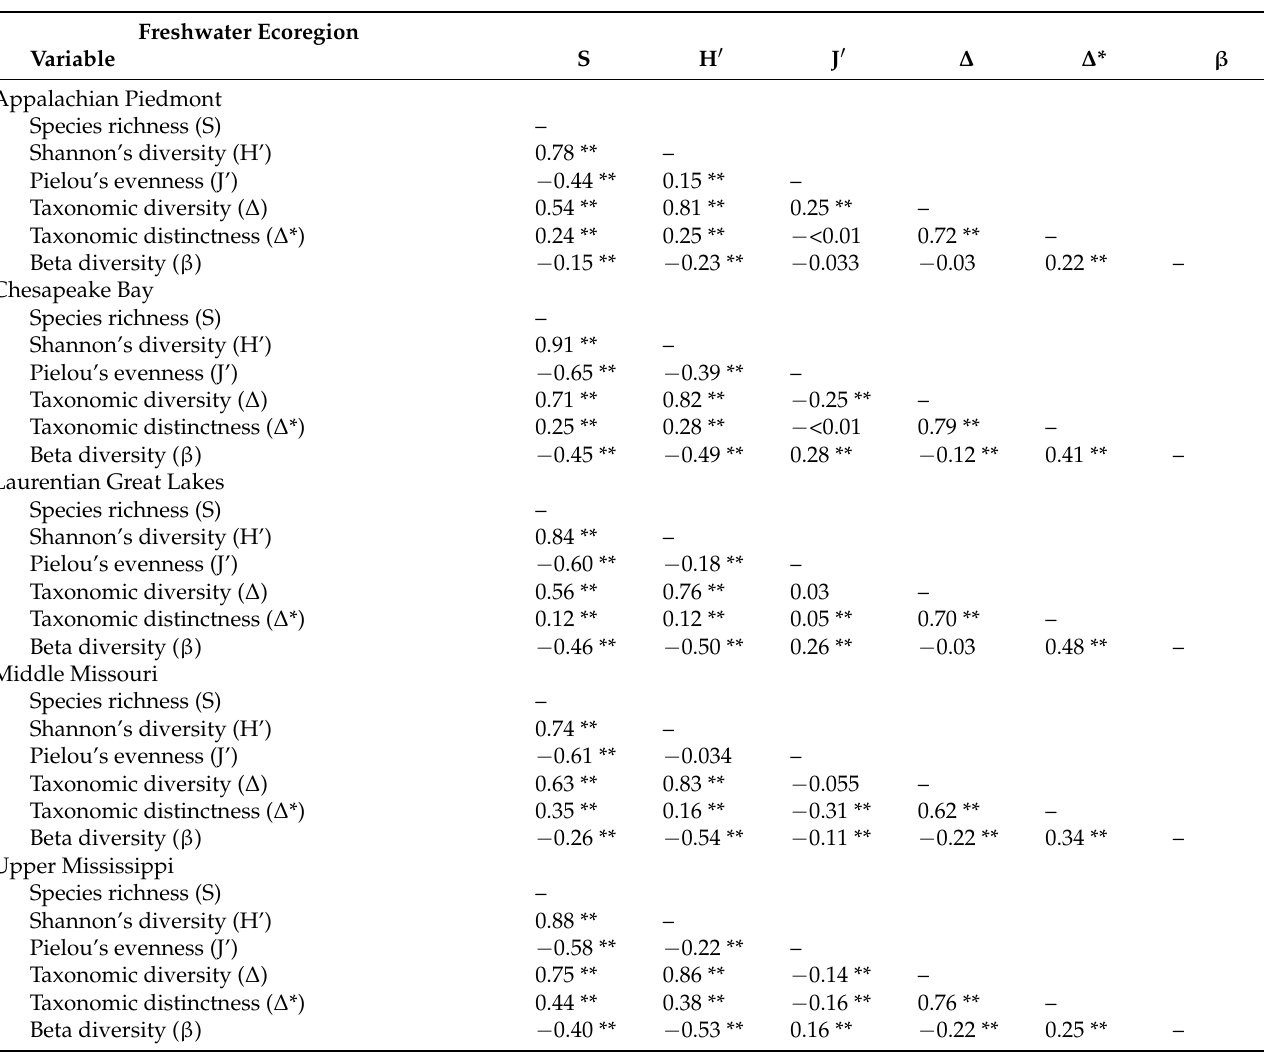
Table 3. Pearson’s correlation (r) between the six biodiversity indices for the five study freshwa- ter